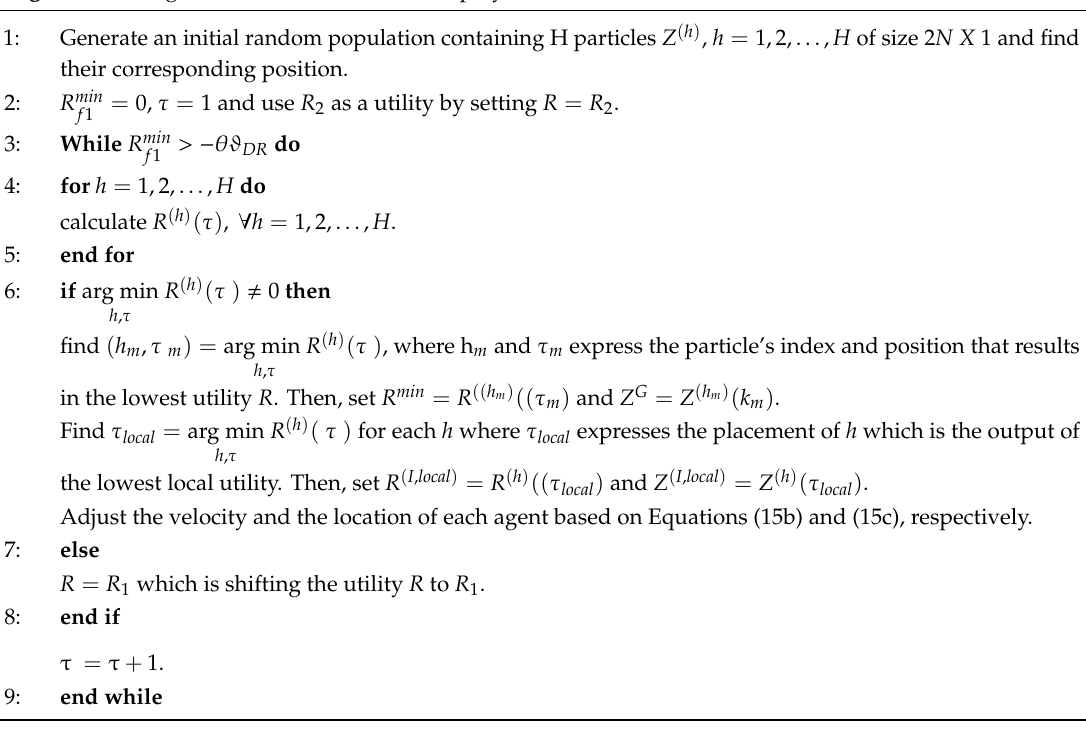
Algorithm 1: Algorithm for UMa and UMi